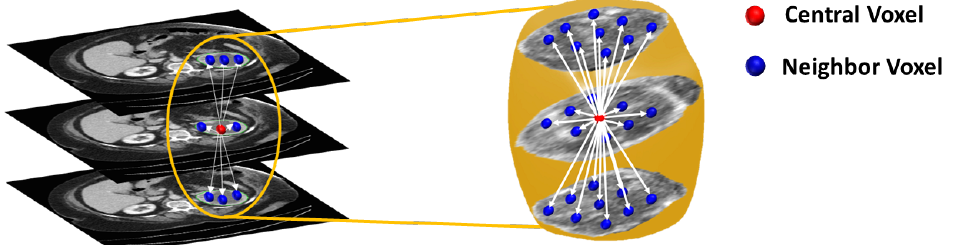
Figure 7. Visualization of the rotation-invariant neighborhood calculation system used to construct the grey-level co-occurrence matrix (GLCM). The GLCM can be constructed by counting the oc- currence frequency of different grey-level pairs in-plane and in adjacent planes accounting for the 26-neighbor voxels (blue) of the central voxel